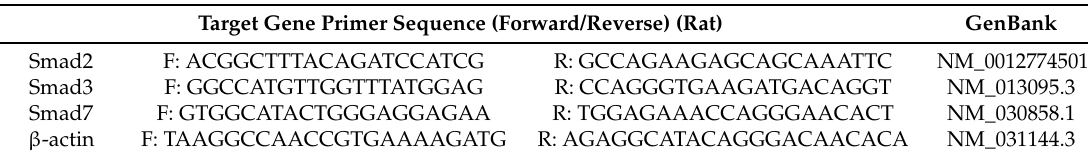
Table 4. Primer sequences for